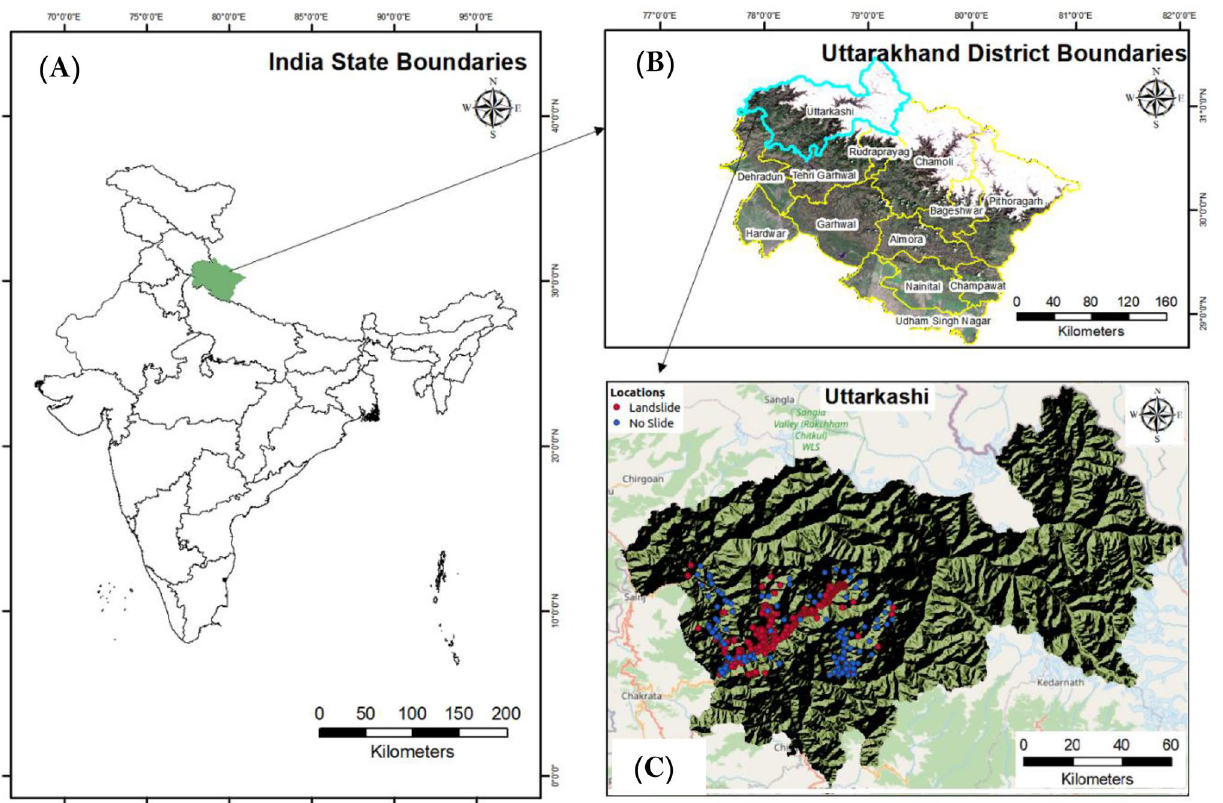
Figure 1. Location map of the study area ( A ) state boundaries of India and study area (Uttarakhand state) ( B ) district boundaries of Uttarakhand state with Uttarkashi district highlighted and ( C ) showing the landslide (red) and non-landslide(blue) locations of Uttarkashi